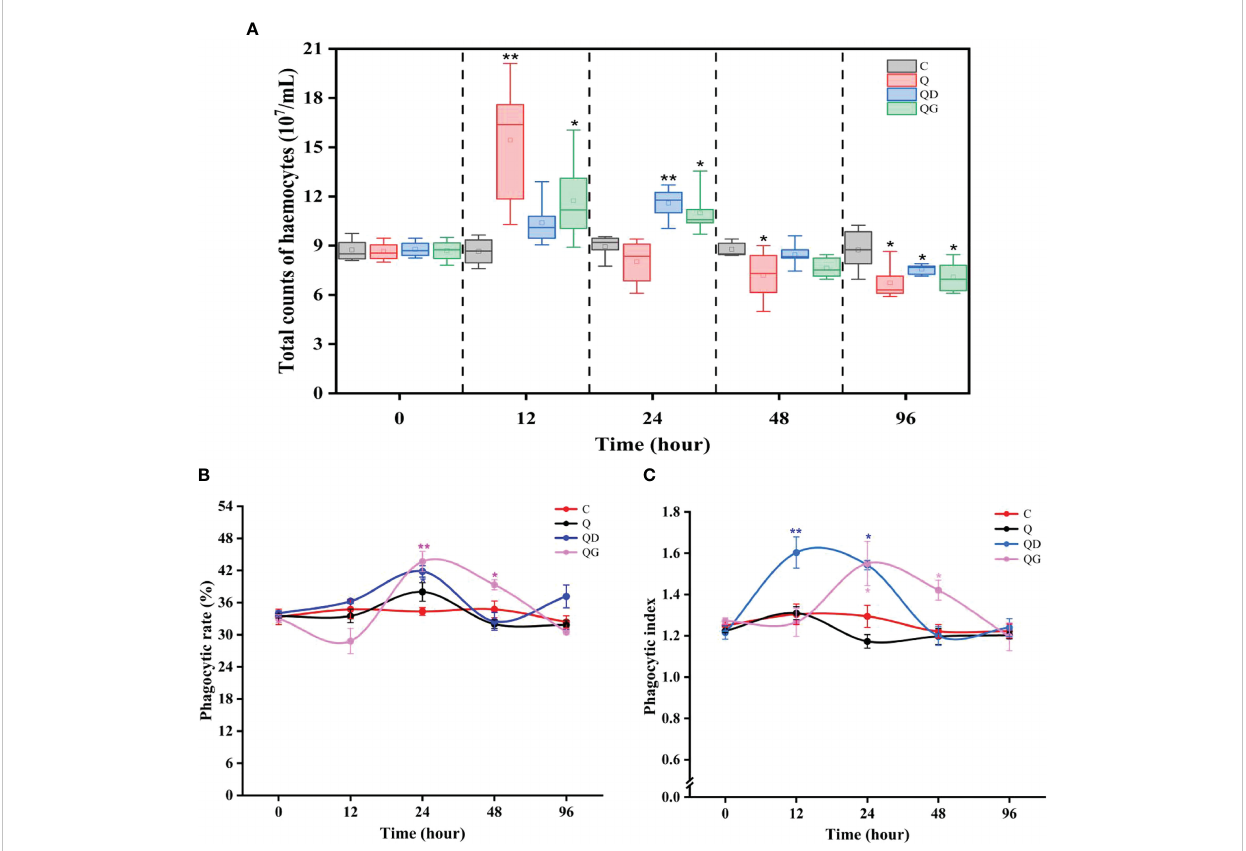
FIGURE 1 Total count of haemocytes (A) , phagocytic rate of haemocytes (B) , and phagocytic index of haemocytes (C) . C, Q, QD, and QG stand for the control group, hypoxia group, hypoxia and mild-sul fi de group, hypoxia and high-sul fi de group, respectively. The asterisk * and ** indicate signi fi cant difference ( P < 0.05) and highly signi fi cant difference ( P < 0.01) compare to the